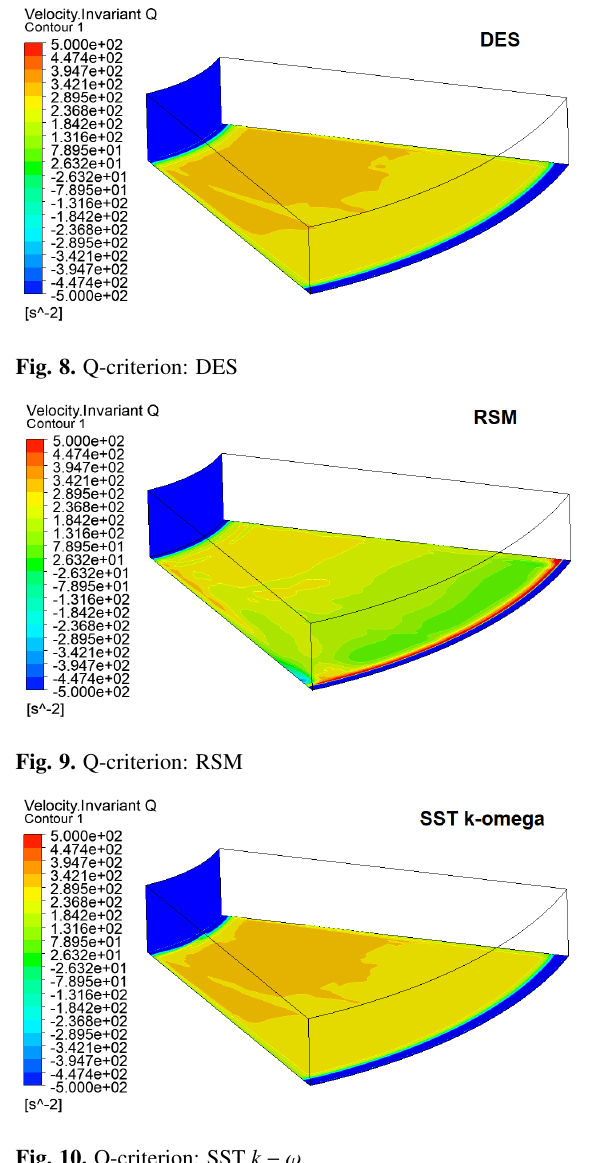
Fig. 10. Q-criterion: SST k − ω